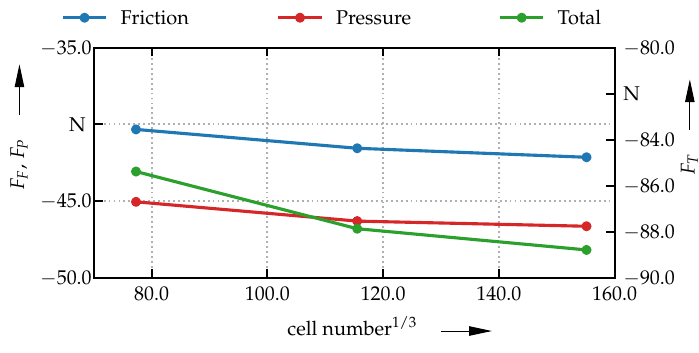
Figure 14. Convergence history, time history of earth fixed longitudinal force for one demi-hull, sinkage and trim for straight-ahead motion with stepwise adjustment of sinkage and trim.